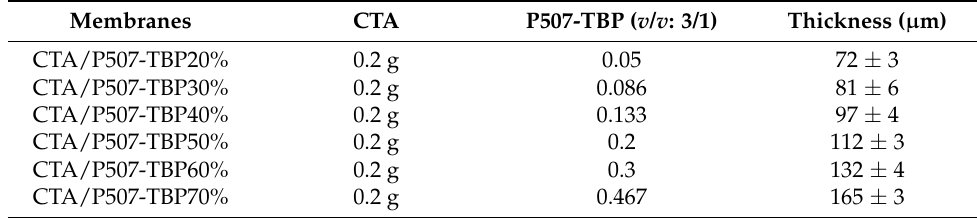
Figure 1. Schematic diagram of preparing CTA/P507-TBP membranes. Table 1. The compositions and thicknesses of PIMs.